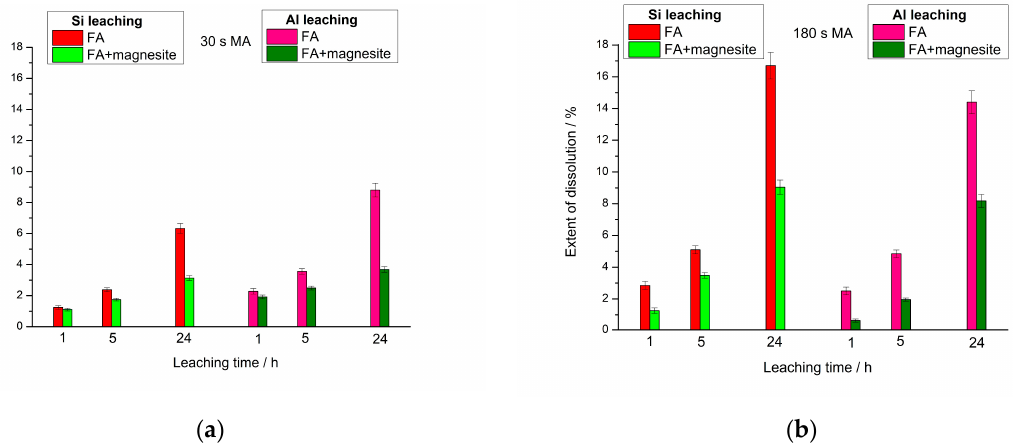
Figure 9. Silicon and aluminum dissolution from the FA and (90% FA + 10% magnesite) blend mechanically activated for: ( a ) 30 s; ( b ) 180 s.